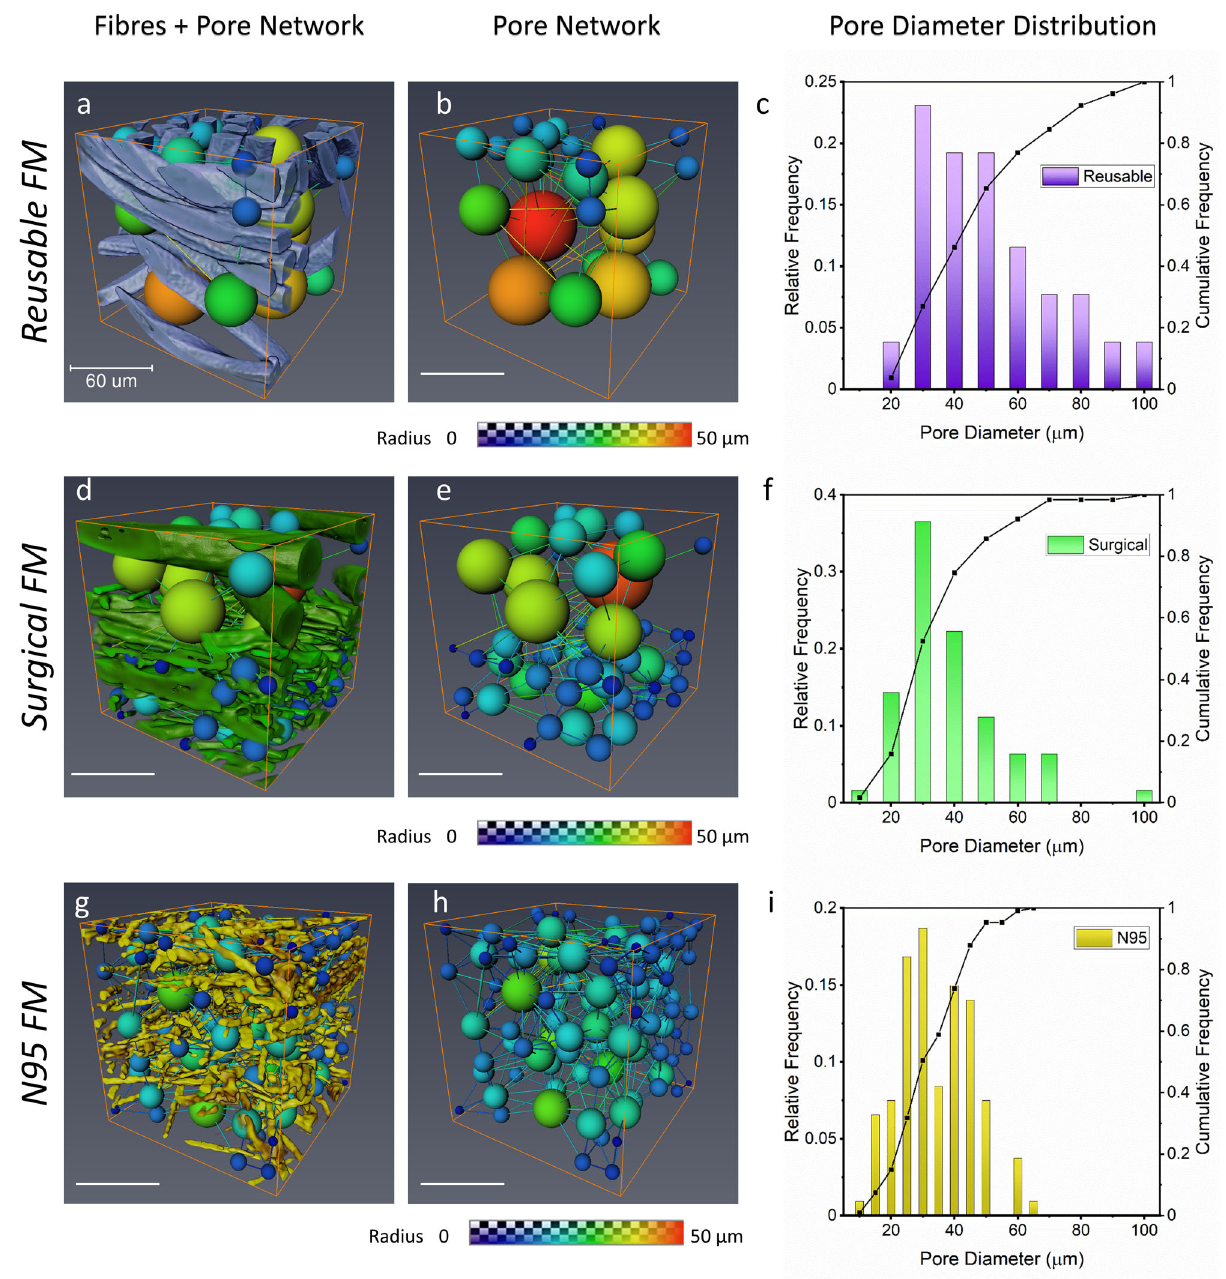
Fig. 2 The pore networks modelling (PNM) of the three commercial face masks and their pore diameter distribution. The air phase (as shown in Fig. 1) is represented as a series of spheres connected by narrower throats (shown as lines). The assigned-colour spheres represent pores scaled according to their equivalent radius (in the range of 0 – 50 µ m). The fi bres superimposed with pore networks are shown in a , d , g the pores and throats b , e , h indicate the porosity within the sample volume. The associated pore diameter distributions c , f , i are quanti fi ed to evaluate the droplets fi ltration ef fi ciency when cough or